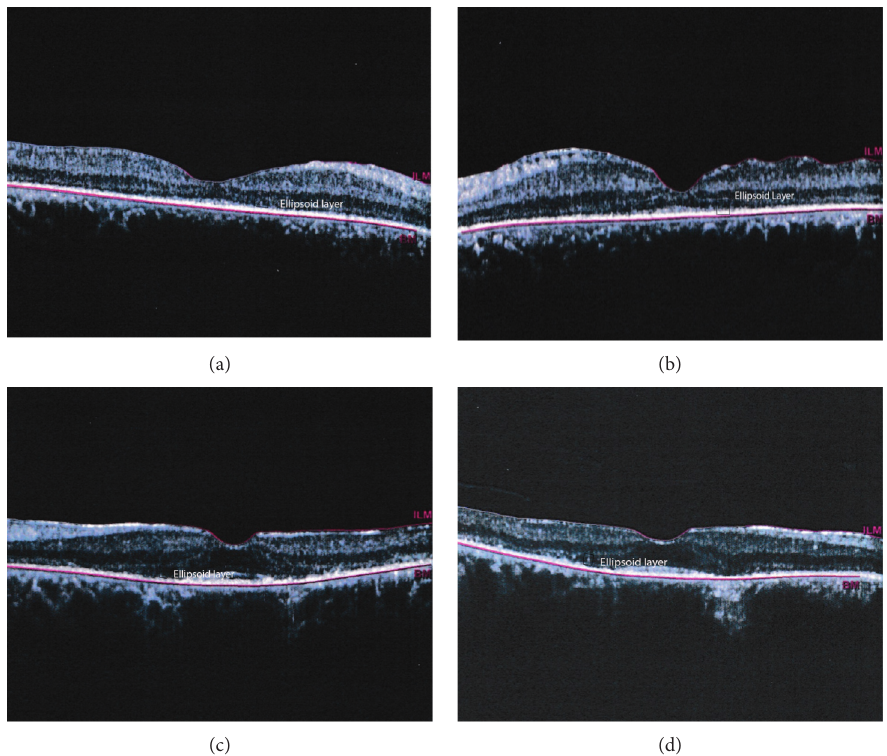
Figure 3: Structural OCT (Heidelberg Engineering): (a) and (b) images showing perifoveal ellipsoid zone disruption of the patient’s right eye and left eye, respectively. (c) and (d) Images showing the offspring’s right eye and left eye, respectively, with greater ellipsoid loss in both eyes compared to his